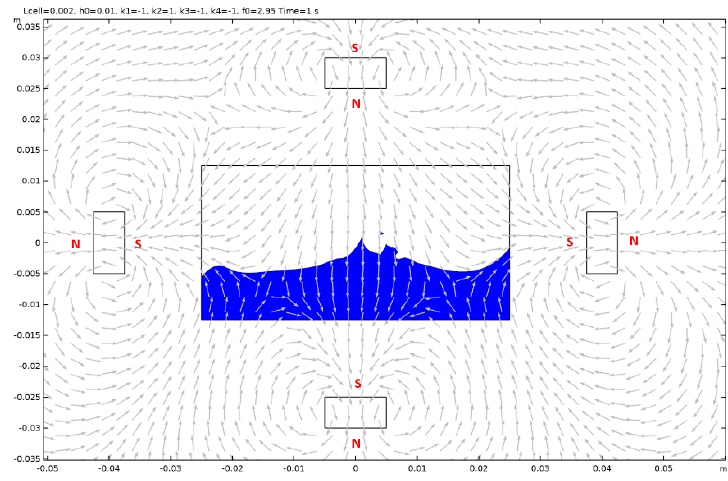
30 of 37 Figure A17. Case 3.